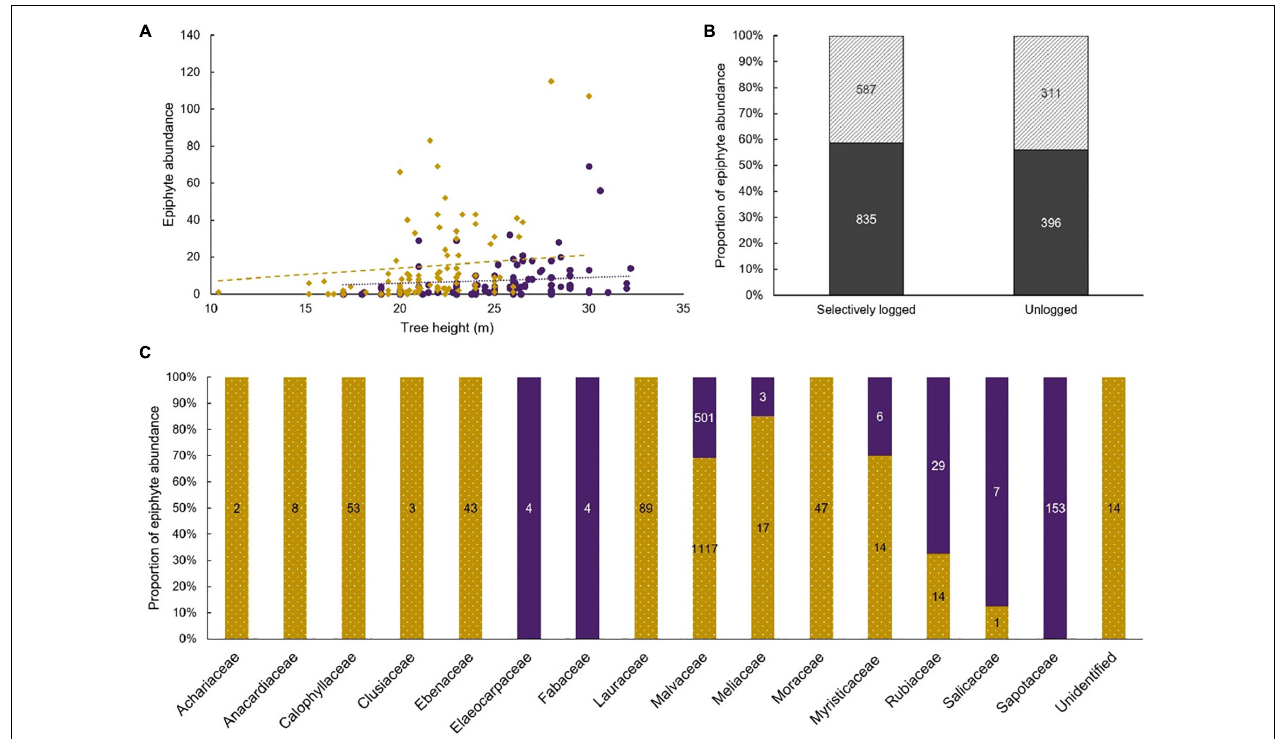
FIGURE 5 | Epiphyte abundance was positively associated with increasing tree height (A) . Associations within the unlogged forest (purple dots) and the selectively logged forest (gold diamond) are shown along with trendlines for unlogged (purple dotted) and selectively logged (gold dashed); similar proportions of epiphytes were found in the riparian (diagonal stripes) and non-riparian (solid gray) microhabitats of both the unlogged and the selectively logged forest (B) . Abundance values are depicted on respective bars, and epiphyte abundance was positively associated with host tree species in the family Ebenaceae, Elaeocarpaceae, Malvaceae, and Rubiaceae. The proportion of epiphyte abundance for each host tree family in the unlogged (solid purple) and the selectively logged forest (dotted gold) are depicted (C) . species), Malvaceae (2 host tree species), and Rubiaceae (1